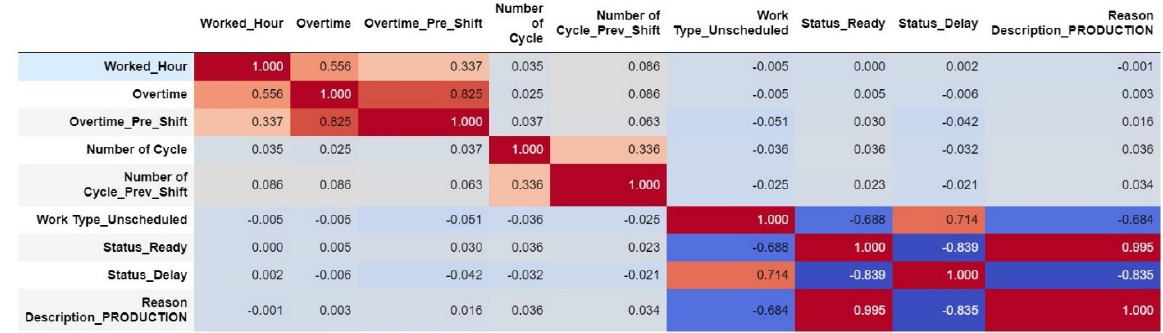
Figure 2. Correlation of the variables.